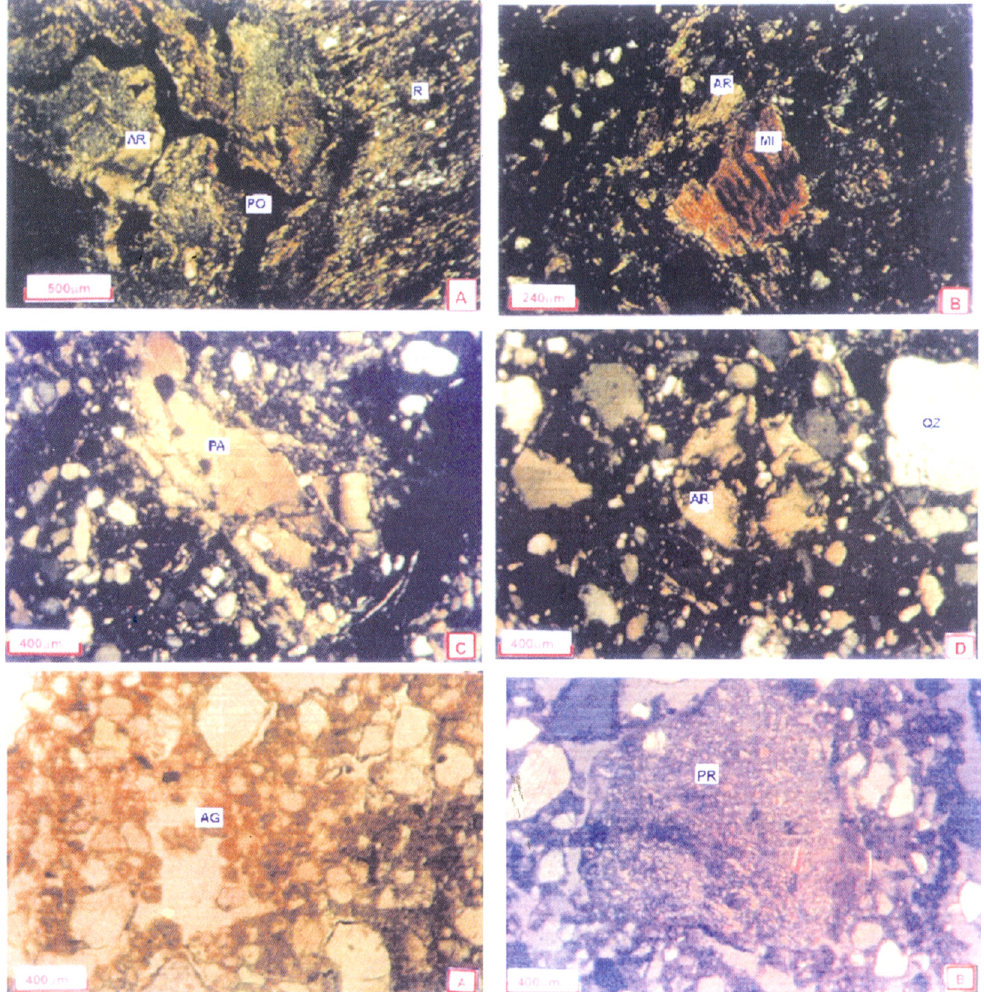
XPL/2.Figura 6. Fotomicrografias. A – nididez da transição entre a rocha (R) e o material edafizado e a presença de argilãs (AR) na camada 2R do perfil 1, em XPL; B – mica alterada e argilãs de intemperização (AR) no horizonte 2BC do Perfil 2, em XPL; C – pápulas (PA) no horizonte 2Btbn do perfil 3, em XPL; D - Argilã (AR) na forma de preenchimento no horizonte 2Btbn do perfil 3, em XPL. PO e QZ representam poros e grãos de quartzo,